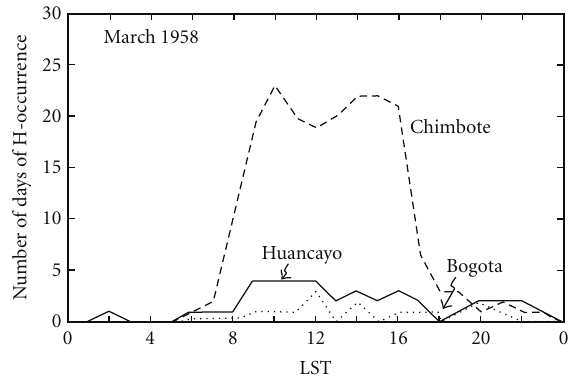
Figure 2: The number of days on which the stratification of the F2 layer has been observed (from Huang